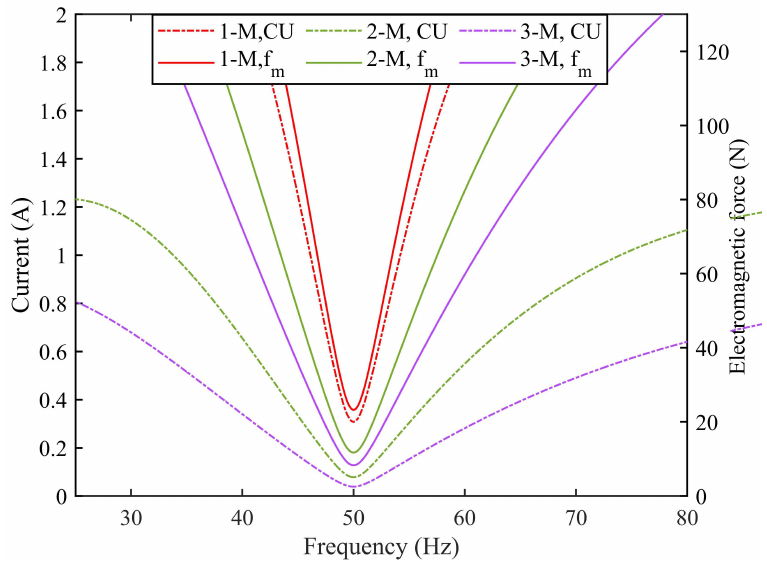
Figure 19. Thrust force and input current of TMM-LOA at different operating frequencies. The stroke-to-current ratio can be found using Equation (12). The stroke-to-current ratio is a function of input frequency and provides a maximum value at the resonance frequency. Figure 20 presents the stroke to the current ratio of proposed TMM-LOA with one, two and three modules, which shows that it has a maximum value at the resonance